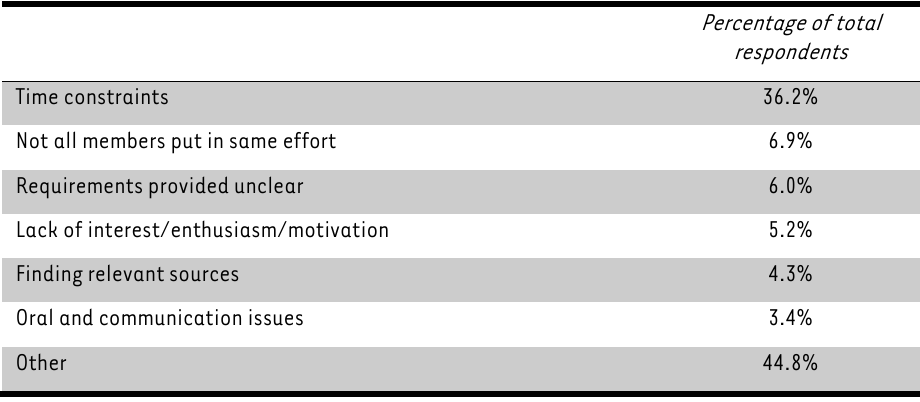
Main perceived constraints of the management accounting simulation and